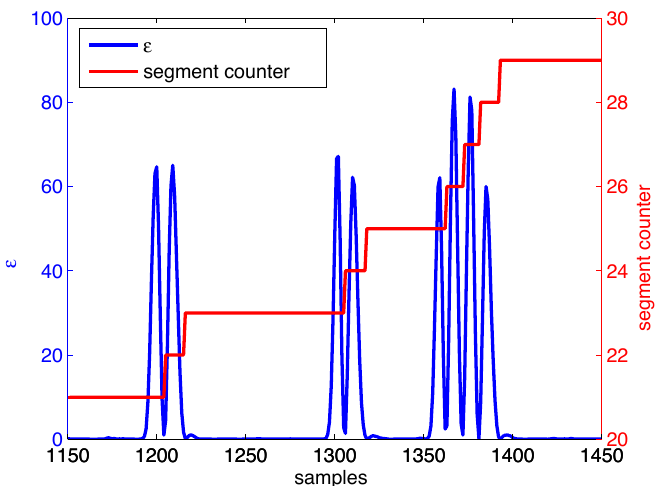
Figure 3. Example of motion segmentation based on (cid:101) , including corresponding segment